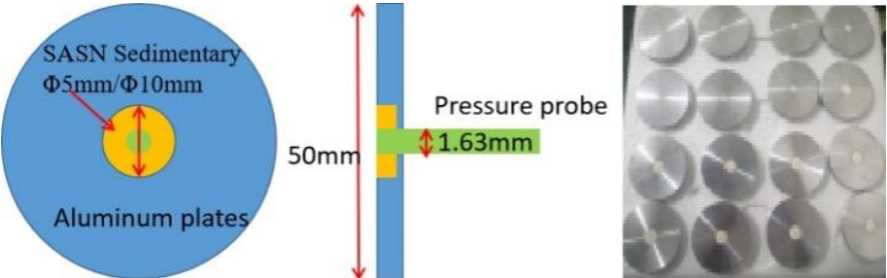
Figure 9. SASN specimen for ignition experiment. Table 3. SASN specimen parameters.